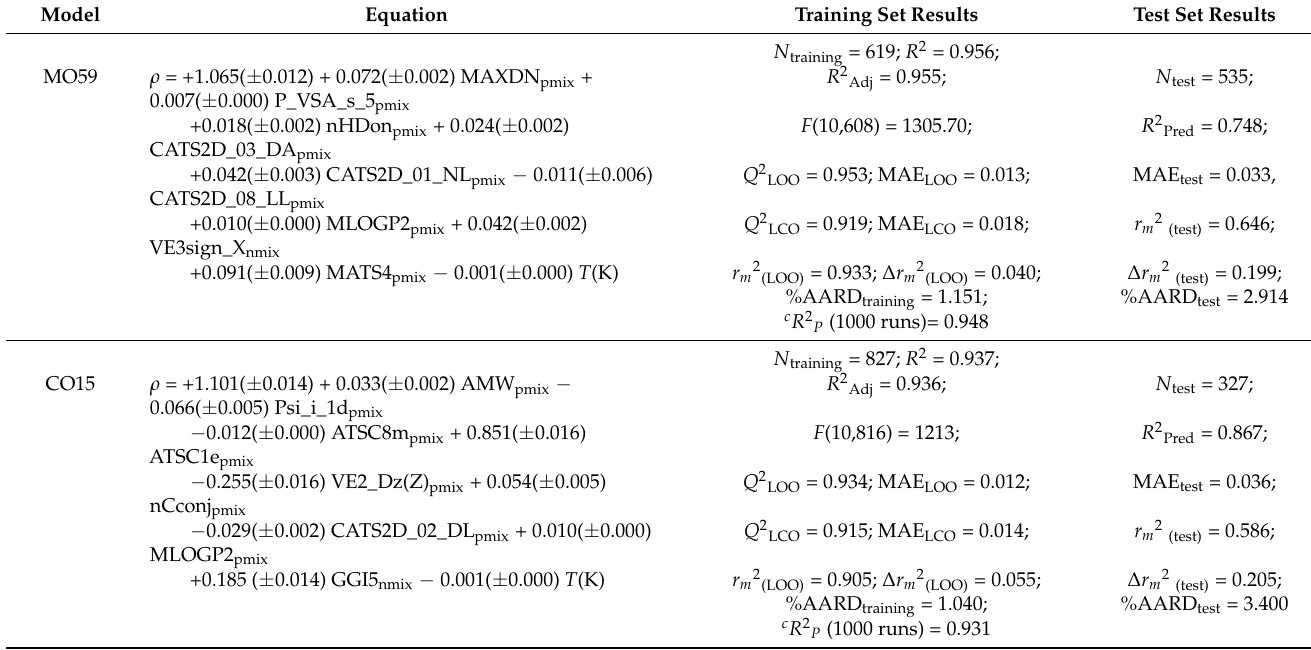
Table 3. Best models derived for the DES’ density ( ρ in g/cm 3 ) along with their MLR statistical parameters, using MO- and CO-based techniques (models MO59 and